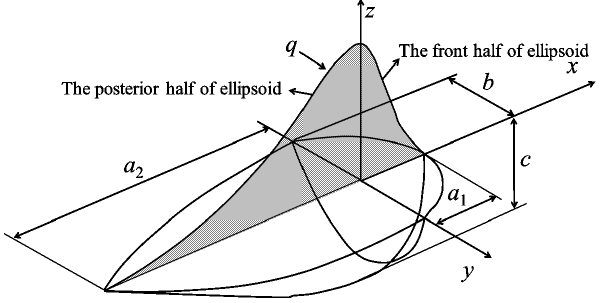
Figure 7. Double-ellipsoidal heat source model.